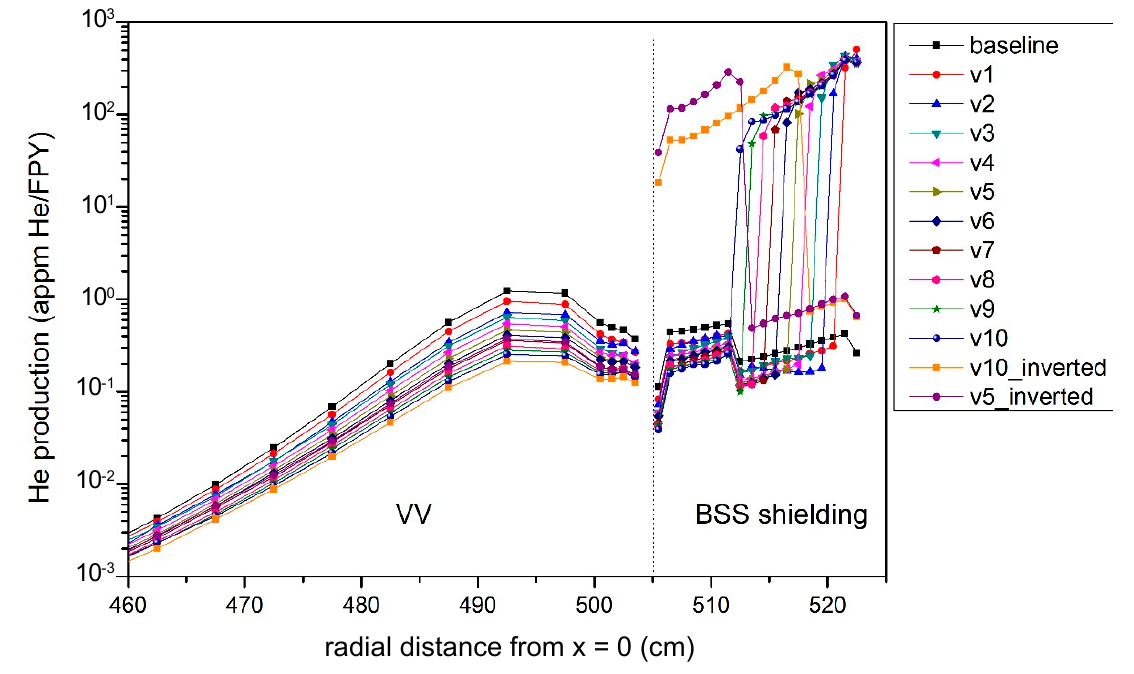
Figure 7. Helium production for the baseline model, the 10 modified versions, and inverted versions v5 and v10 from the BSS to the VV.